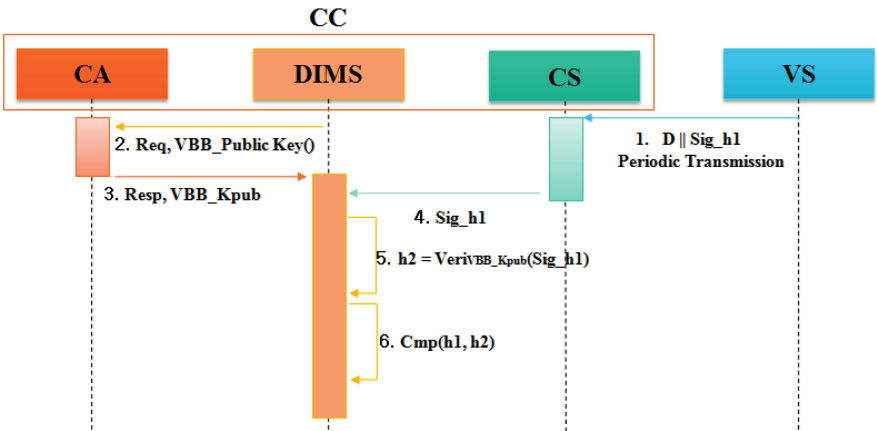
Figure 4. VBSM of special cases